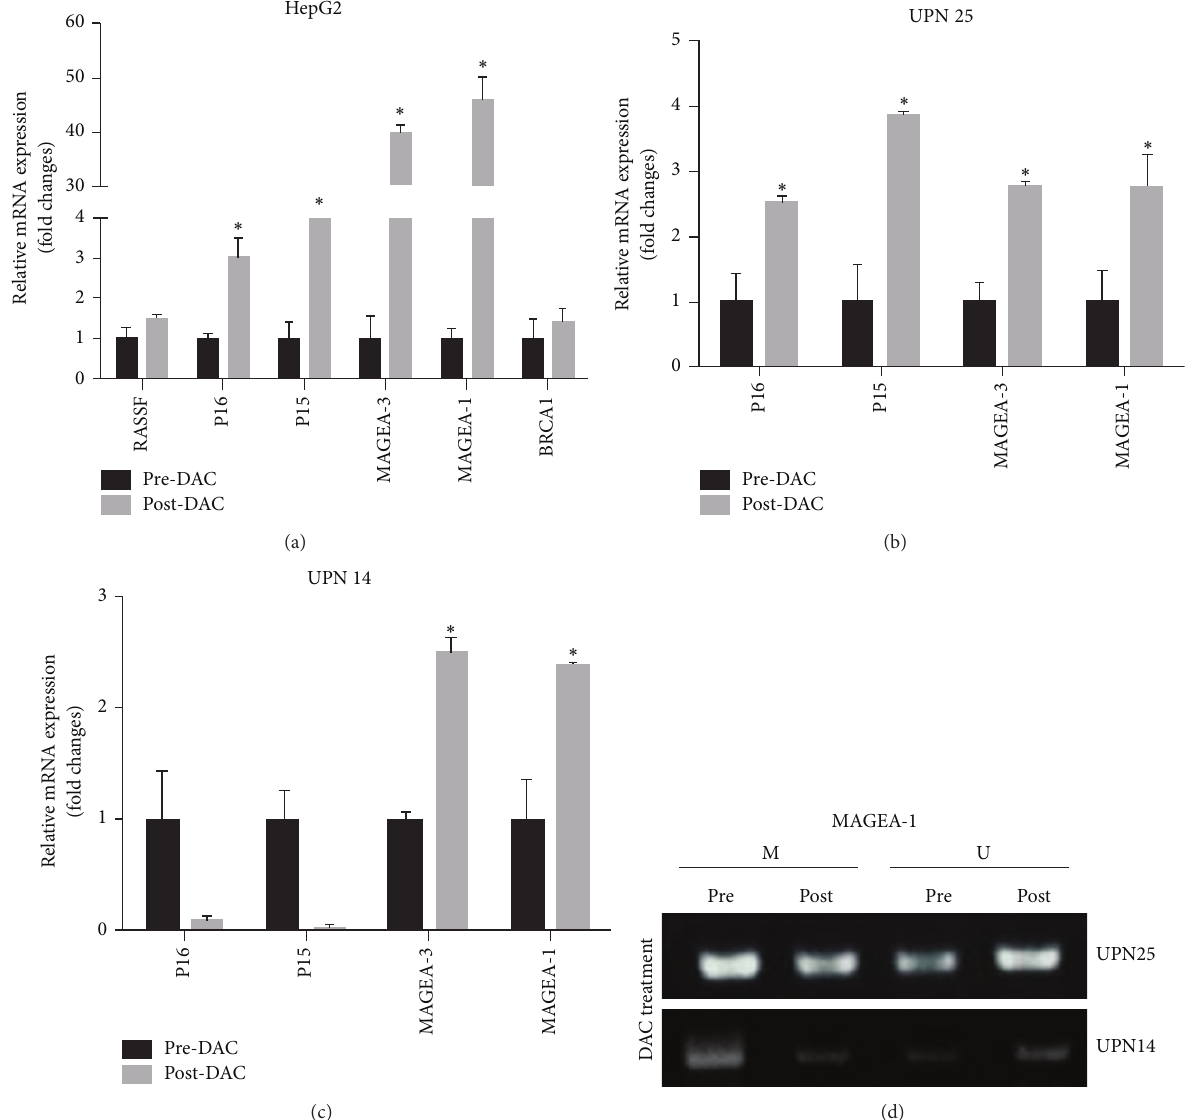
Figure 5: In vivo and in vitro biological activities of decitabine (DAC) were shown in human hepatocellular carcinoma HepG2 cell line and peripheral blood mononuclear cells (PBMCs). (a) Quantitative RT-PCR analyses of the mRNA levels of RASSF1A, MAGEA-3, MAGEA-1, p16, p15, and BRCA1 expression on human hepatocellular carcinoma HepG2 cell line; the cell lines were treated with 10 nM DAC for 72 h before collecting mRNA for analysis. Compared to untreated control, the mRNA expression levels of MAGEA-3, MAGEA-1, p16, and p15 were augmented significantly in treated cell line. ((b), (c)) Quantitative RT-PCR analyses of the mRNA levels of MAGEA-3, MAGEA-1, p16, and p15 expression in peripheral blood mononuclear cells (PBMCs) from patients who exhibited prolonged disease stabilization following low-dose DAC treatment for the first cycle. Progressive increases in the mRNA expressions of MAGEA-3, MAGEA-1, p16, and p15 were observed in patient UNP 25; in contrast, the p16 and p15 mRNA expressions were reduced in patient UNP 14. (d) Methylation-specific PCR analyses of the changes in MAGEA-1 promoter methylation levels in peripheral blood mononuclear cells (PBMCs) collected from patients UNP 25 and UNP 14, during the first treatment cycle. The levels of MAGEA-1 promoter methylation of patients UNP 14 and UNP 25 were reduced and the levels of MAGEA-1 promoter unmethylation were increased at the same time. M: methylation; U: unmethylation. ∗ 𝑃 < 0.05 , for the significance of the gene expressions differences between the DAC treatment sample and the pre-DAC sample. Error bars represent standard deviation of the